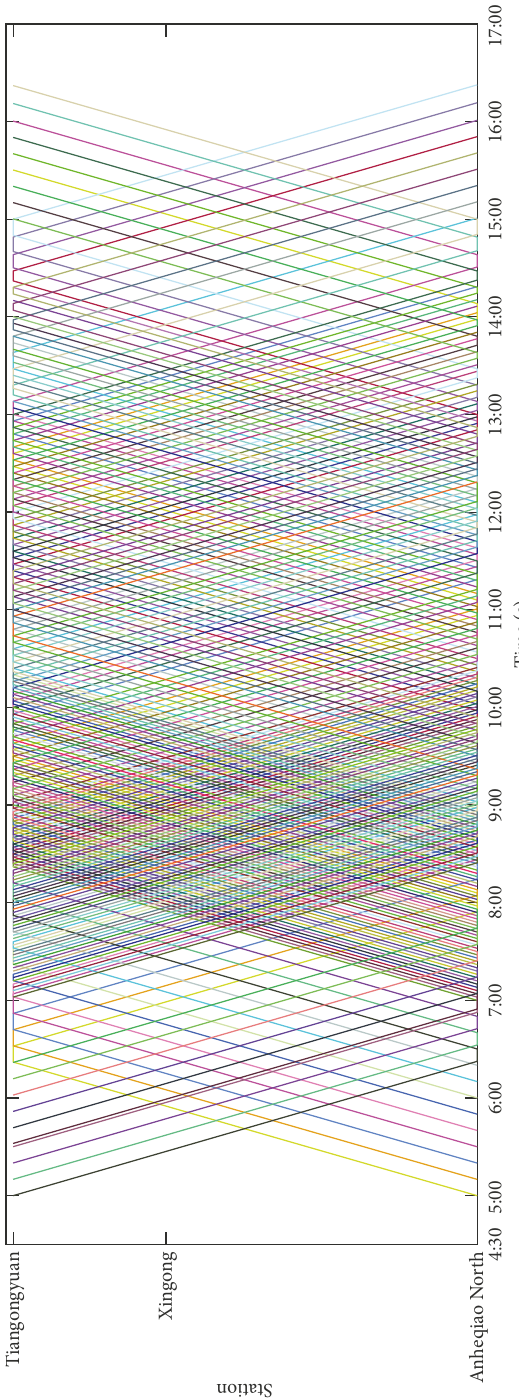
Figure 12: Optimal train schedule without short turning strategy for case